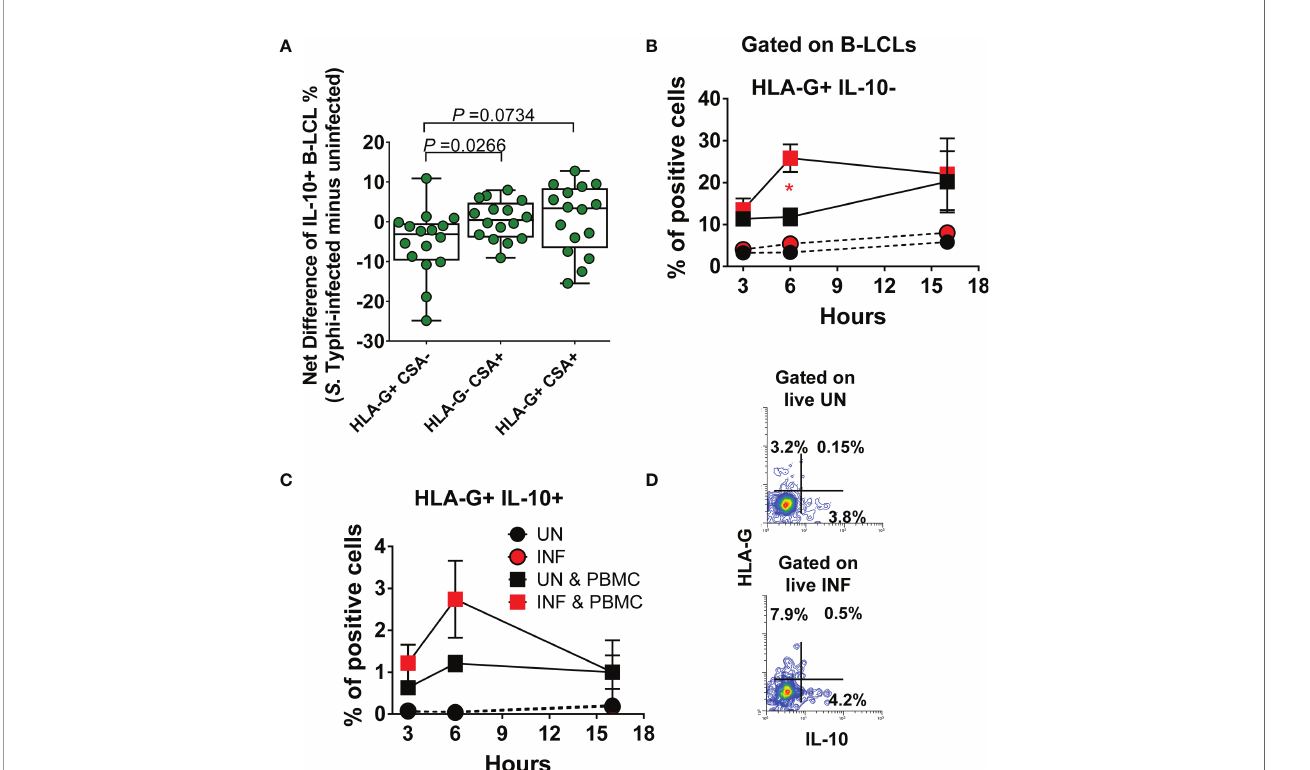
FIGURE 6 | Effect of S. Typhi infection on B cell function. B-LCLs were infected with S. Typhi for 3 hours at 1:10 multiplicity of infection (MOI). Uninfected cells were used as controls. After 16-18 hours of gentamicin treatment, cells were co-cultured with PBMC. After 3, 6 and 16 hours of co-culture, cells were collected, and the B cell expression of CSA, HLA-G, and IL-10 were evaluated by fl ow cytometry. (A) Levels of IL-10 among B-LCL subsets (i.e., HLA-G+ CSA-, HLA-G- CSA+, and HLA-G+ CSA+). Bar graphs extend from the 25 th to 75 th percentiles; the line in the middle represents the median of the pooled data. The whiskers delineate the smallest to the largest value. Kinetics of (B) HLA-G+ IL-10- and (C) HLA-G+ IL-10+ expression on UN and INF B-LCLs alone or after exposure to PBMC. For (B, C) and “ C ” , Student ’ s t-test was performed to compare B-LCL subset levels after exposure to PBMC. *, represent signi fi cant differences ( P <0.05) between the UN ( ) and INF B-LCLs ( ) in the presence of PBMC at the same timepoint. (D) A presentative experiment showing the expression of IL-10 on UN and INF